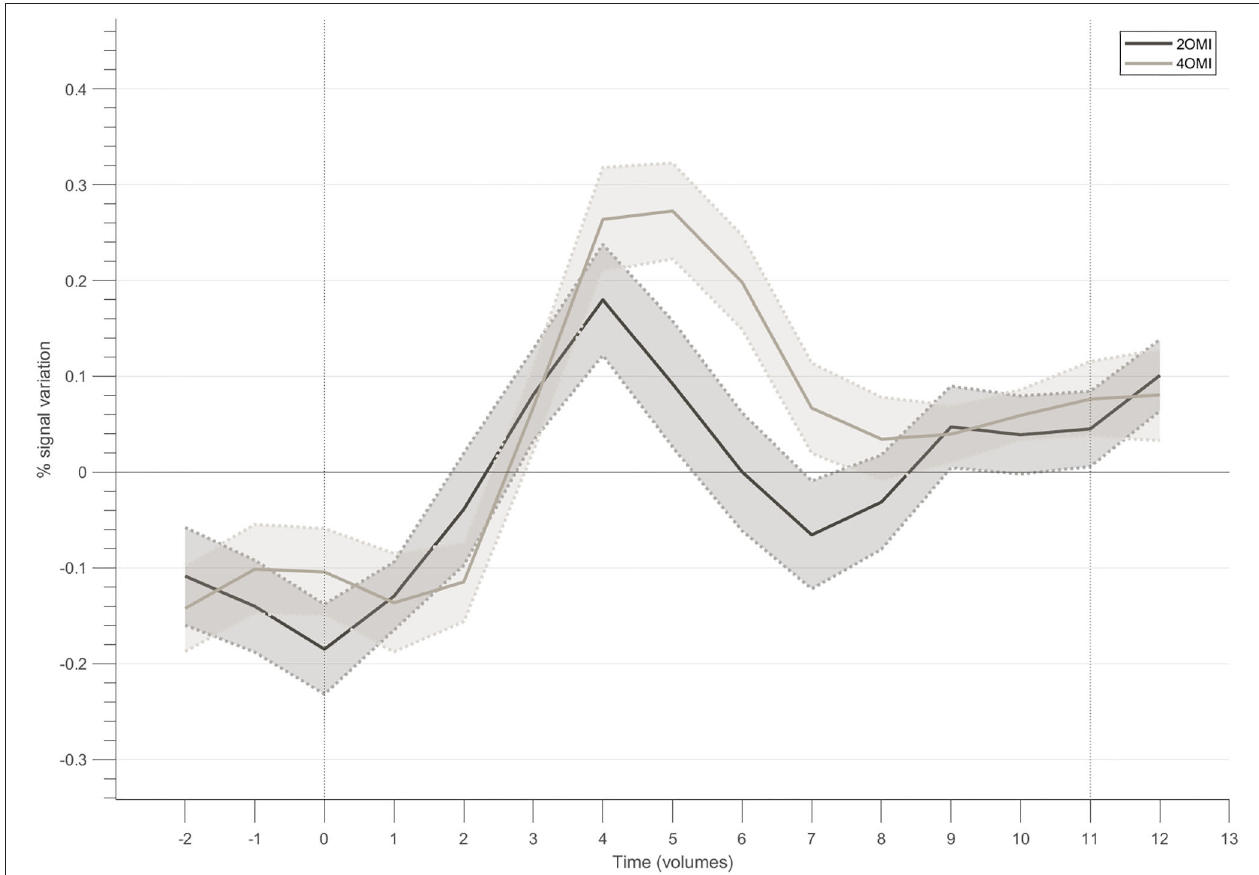
FIGURE 5 | Block-related responses averaged across the participants that successfully modulated the ROI within the neurofeedback target.